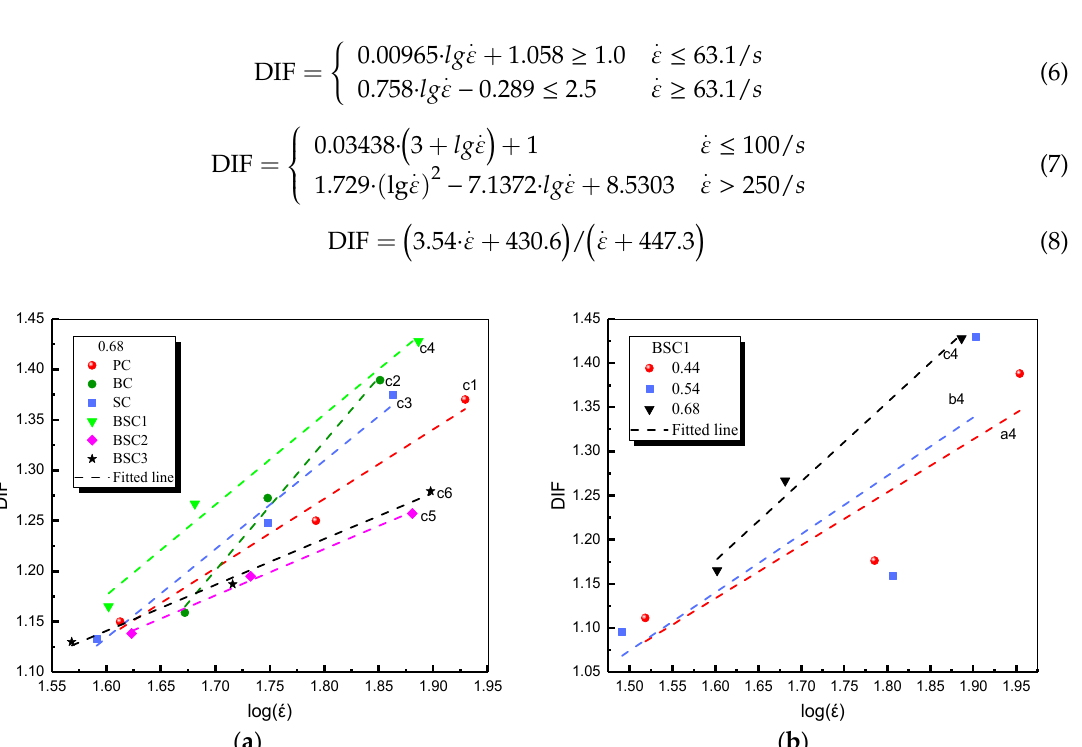
Table 5. The linear fitting results of DIF function.